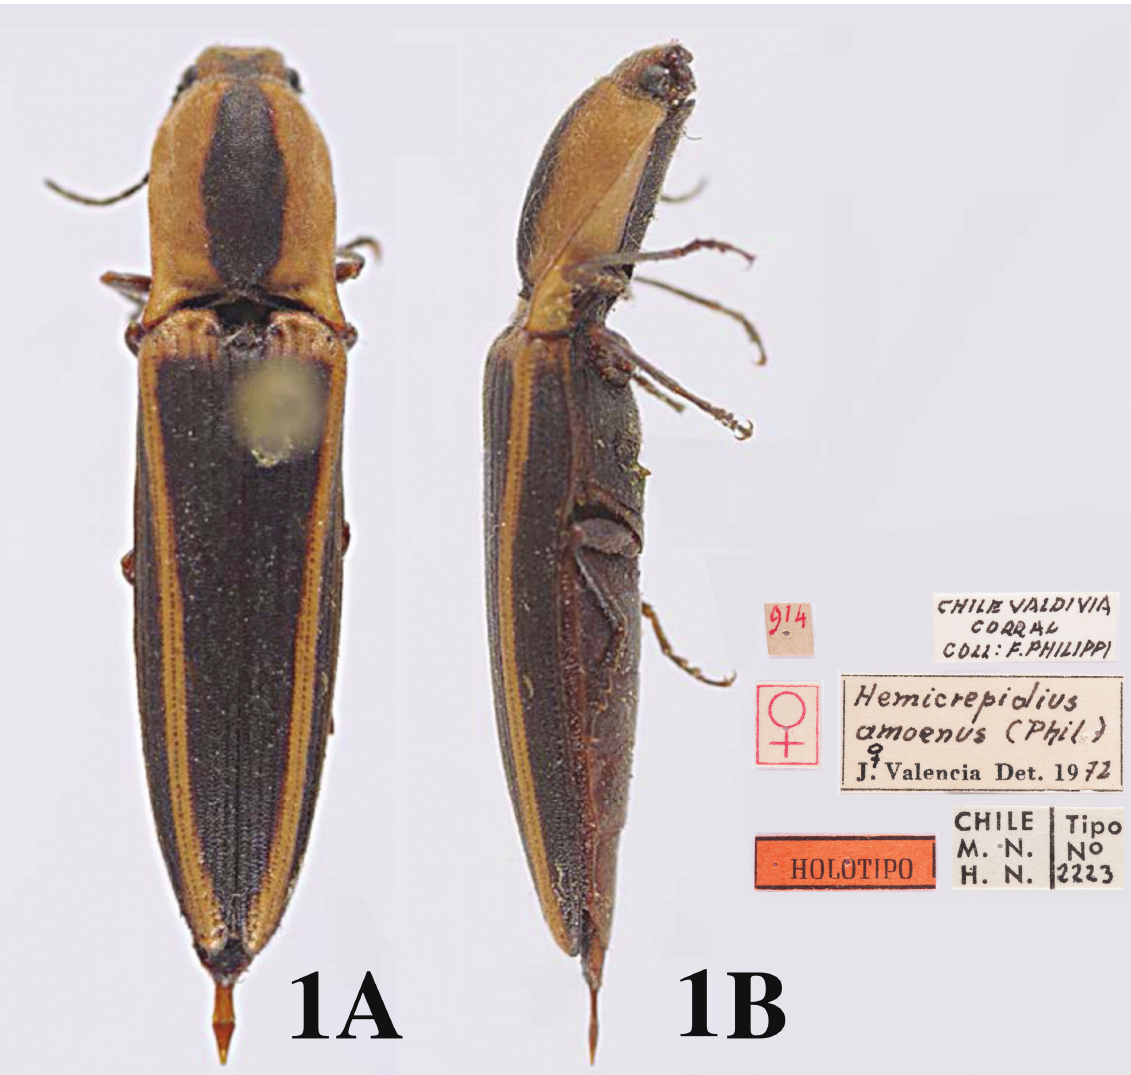
Fig. 1. holotype of Sharon amoenus (Philippi, 1861) comb. nov., ♀, adult (MNNC). A . Dorsal view. B . lateral view. Body length: 14.47 mm. Photo by Cristian